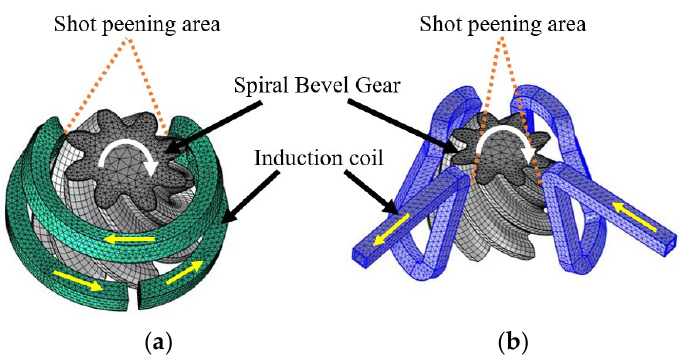
Figure 4. Spiral bevel gear induction heating model: ( a ) transverse coil, ( b ) longitudinal coil.